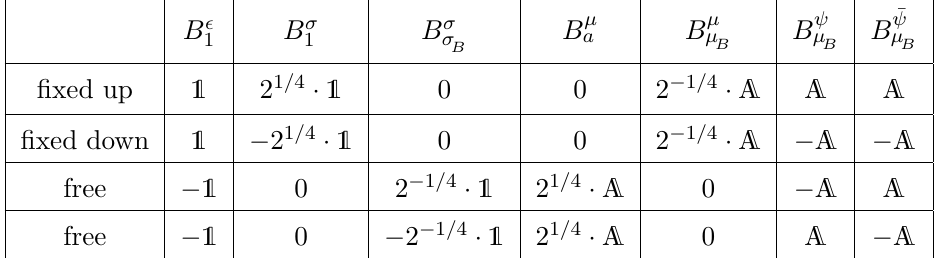
Table 6 . Representations of the boundary classifying super-algebra of the fermionic Ising model. solutions, there are no couplings to the (cid:12)elds a and (cid:27) excluded from the set of boundary (cid:12)elds, as